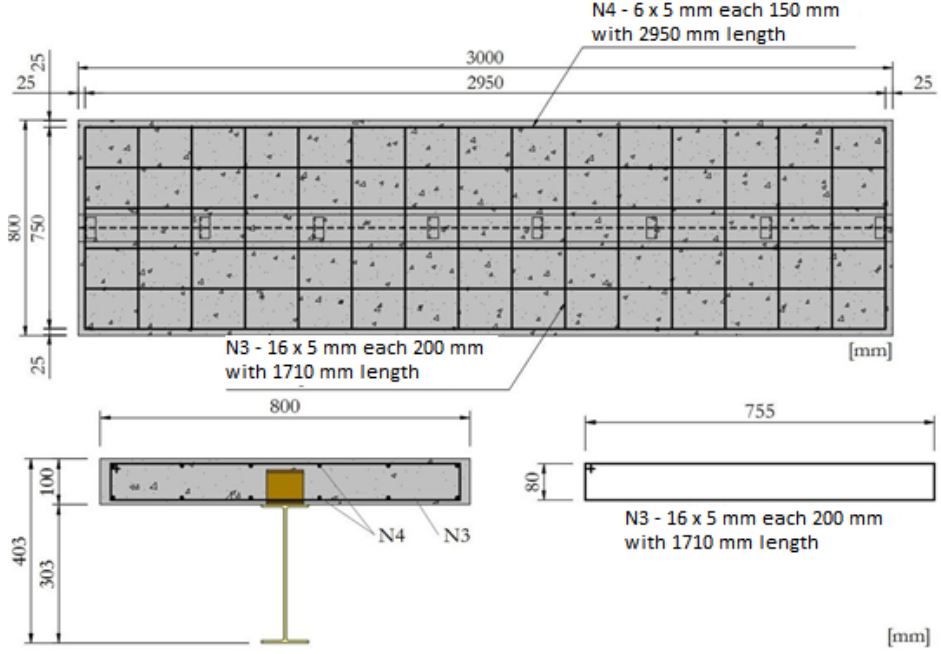
Figure 1. Beam dimensions and concrete slab reinforcement detail.